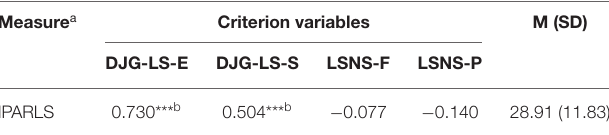
TABLE 3 | Descriptive statistics and correlations matrix between IPARLS and considered criterion